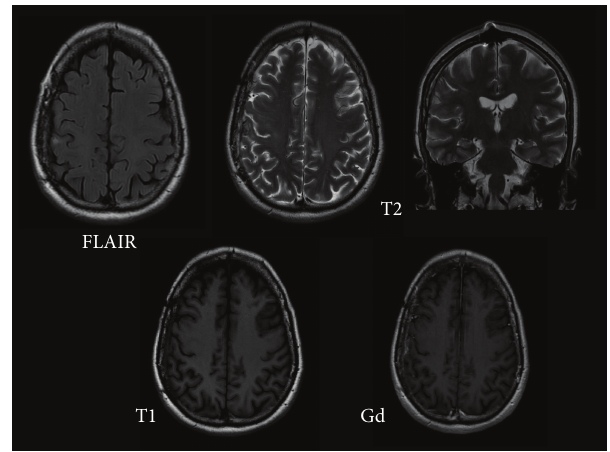
Figure 5: Control brain MRI. Three months after surgery a control brain MRI shows no lesion